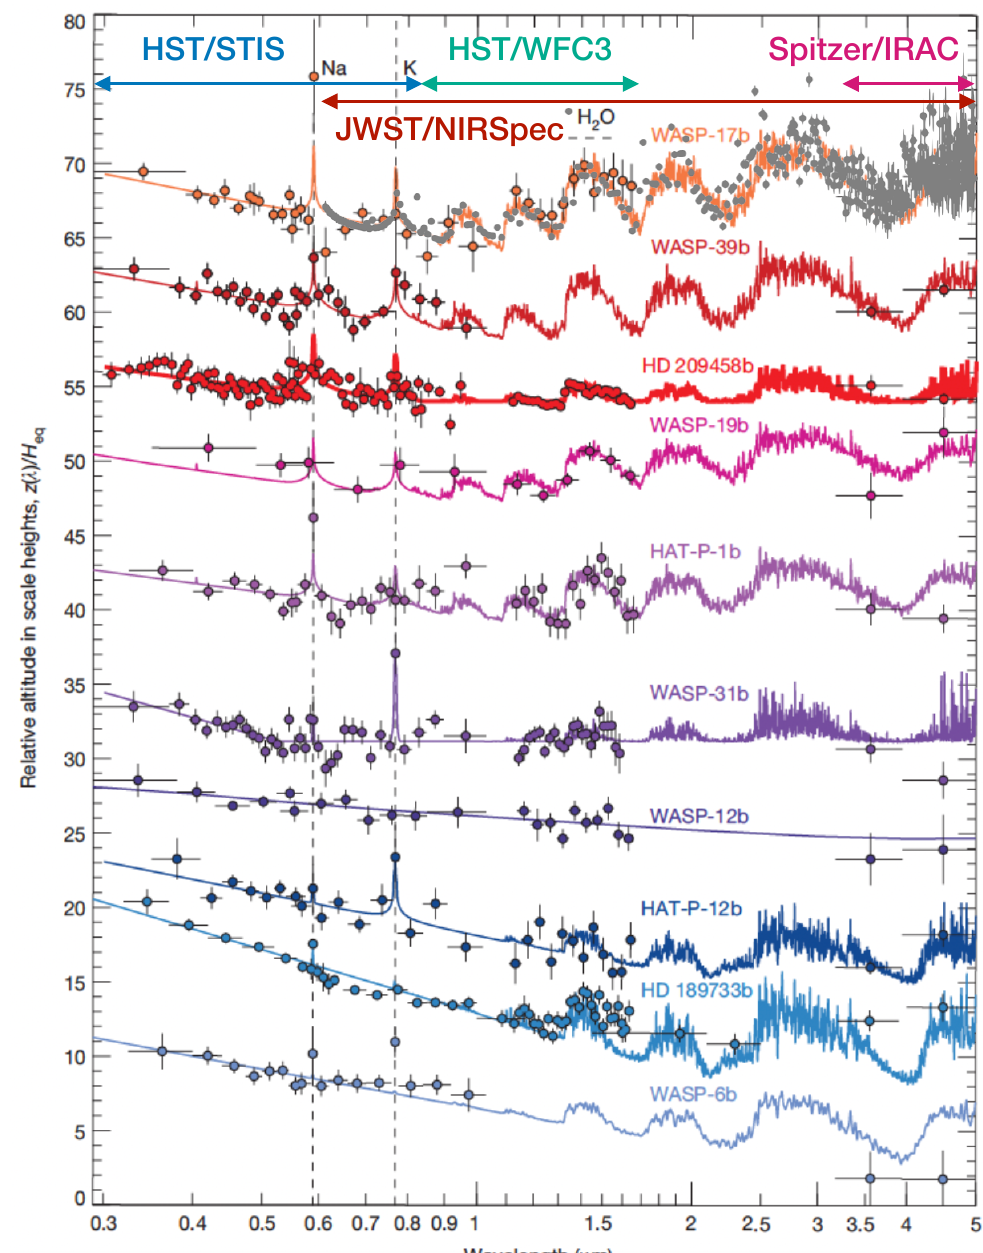
Figure 5. HST/Spitzer transmission spectral sequence of hot Jupiter survey targets from Sing et al. [7]. We sub-plotted in gray a JWST/NIRSpec simulation from Pandexo [45] (50 ppm minimum noise, prsim mode with a resolution of 100) on the first spectrum (WASP-17b) to highlight the major improvements in terms of resolution and wavelength coverage. Solid colored lines indicate the fitted spectra from simple 1D models showing the main spectral features. The spectra have been shifted for a better visualization. Horizontal and vertical error bars indicate the wavelength spectral bin and 1 σ measurement uncertainties, respectively. We have also added the wavelength coverage of the different instruments (STIS, WFC3, IRAC and NIRSpec) to emphasise that NIRSpec alone covers the wavelengths of almost all the other instruments combined. Furthermore, NIRSpec has a much better resolution than the other instruments (in particular, the two points of Spitzer/IRAC) and covers a broad band between 1.7 and 3.5 microns that was not observed by the other instruments. Figure adapted from Sing et al.